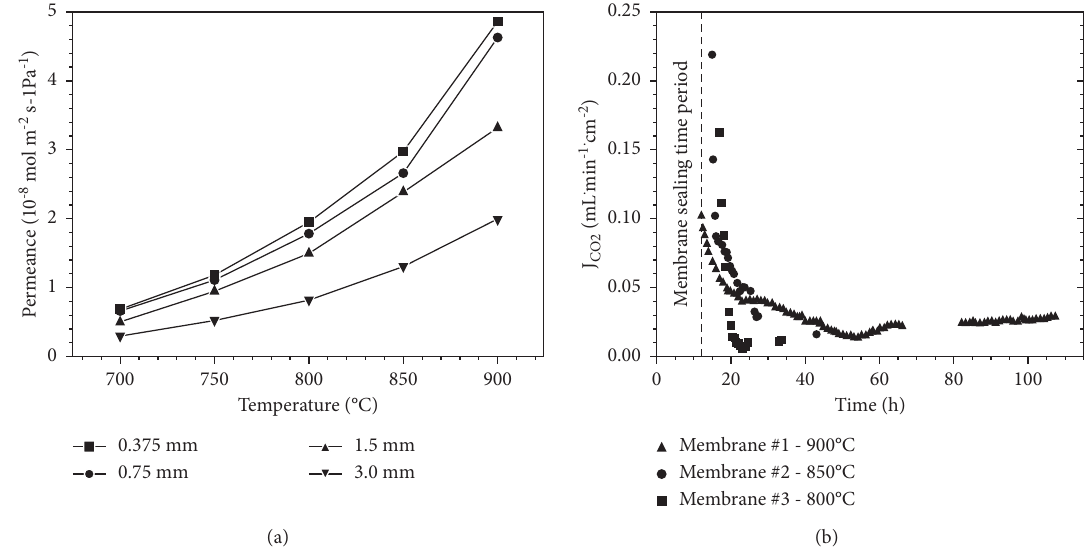
Figure 11: (a) Effect of membrane thickness as a function of temperature on CO 2 permeance [24]; (b) change in CO 2 permeance as a function of time at different temperatures in the absence of O 2 [64]. Table 4: Comparison of CO 2 fluxes and stabilities for different types of MEOCC membranes. Support